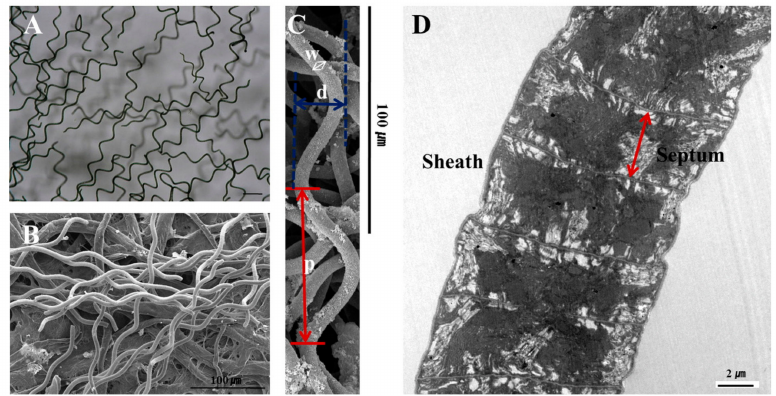
Figure A1. Morphology of Spirulina maxima . ( A ) Light micrograph. Original magnification, 100 × ; ( B ) Scanning electron micrograph. Original magnification, 350 × ; ( C ) The width (w) of the trichomes is 6–12 m, the pitch (p) is 12–72 m, and the diameter (d) is 30–70 m. Original magnification, 500 × ; ( D ) Longitudinal section along the trichome, illustrating the thin, diffluent, fibrillar, net-like sheath enveloping the trichome. The regularly spaced cross walls form a septum that divide the trichome into cells. Original magnification, 8600 × .